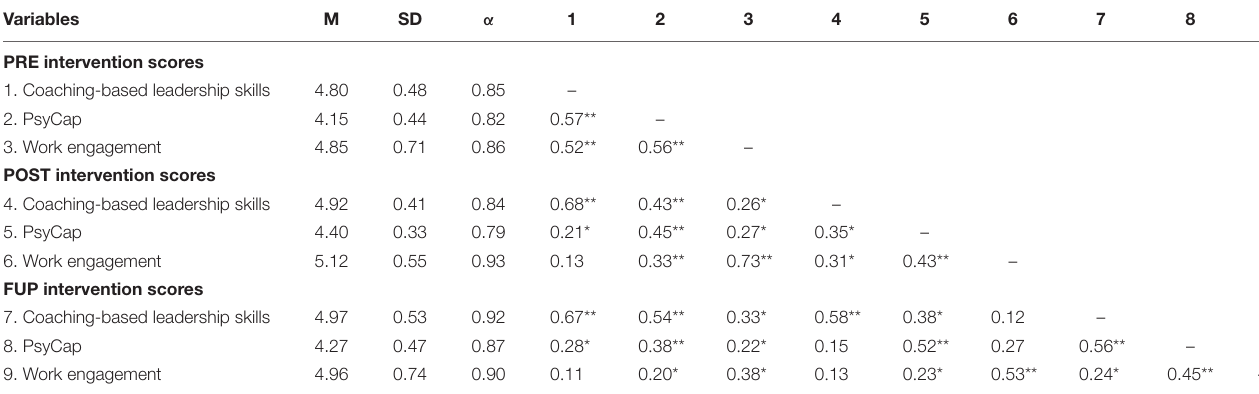
TABLE 2 | PRE, POST, and FUP self-reported means, standard deviations, internal consistencies, and correlations of all variables for the whole intervention group. Variables M PRE intervention scores